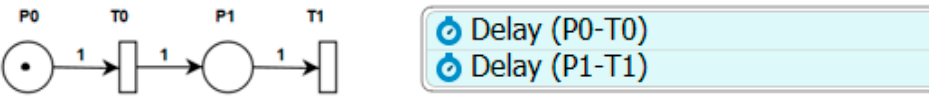
Figure 6. Conflict in Petri net (left) and FlexSim (right). The Decide activity can have one or multiple inputs as well as one or multiple outputs, see Figure 7. Each output is assigned a positive integer number (the first option is 1, the second option is 2, etc.) All inputs enter the Decide activity and exit to the assigned output. Therefore, the deterministic or probabilistic solution of the conflict will depend on the number that is “assigned” to each token, as the number assigned for each output is not changeable. For a deterministic solution, labels (equivalent to colors in a colored Petri net) can be used. These labels can be assigned before the Decide activity or may exist from previous processes. Figure 7. Example of a deterministic decision with FlexSim (label version). Let us imagine that, depending on the weight of the cargo, we will choose one option or another (deterministic decision). Specifically, if the cargo weighs less than 1000 u, it will exit by option 1; otherwise, it will exit by option 2. This can be configured in FlexSim by assigning the labels previously, see Figure 8.